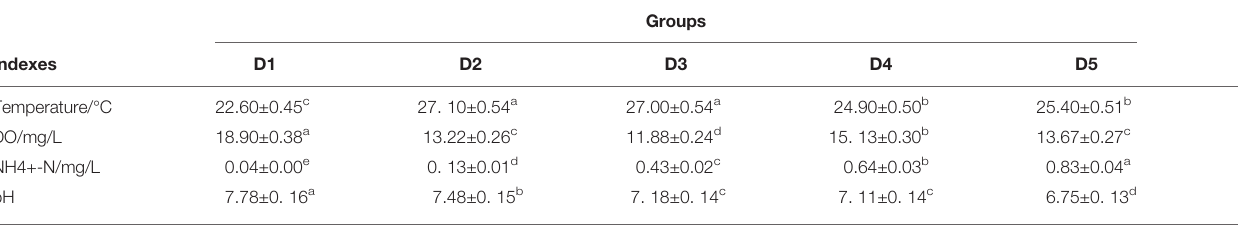
TABLE 2 | Water quality parameters after transportation at different densities.